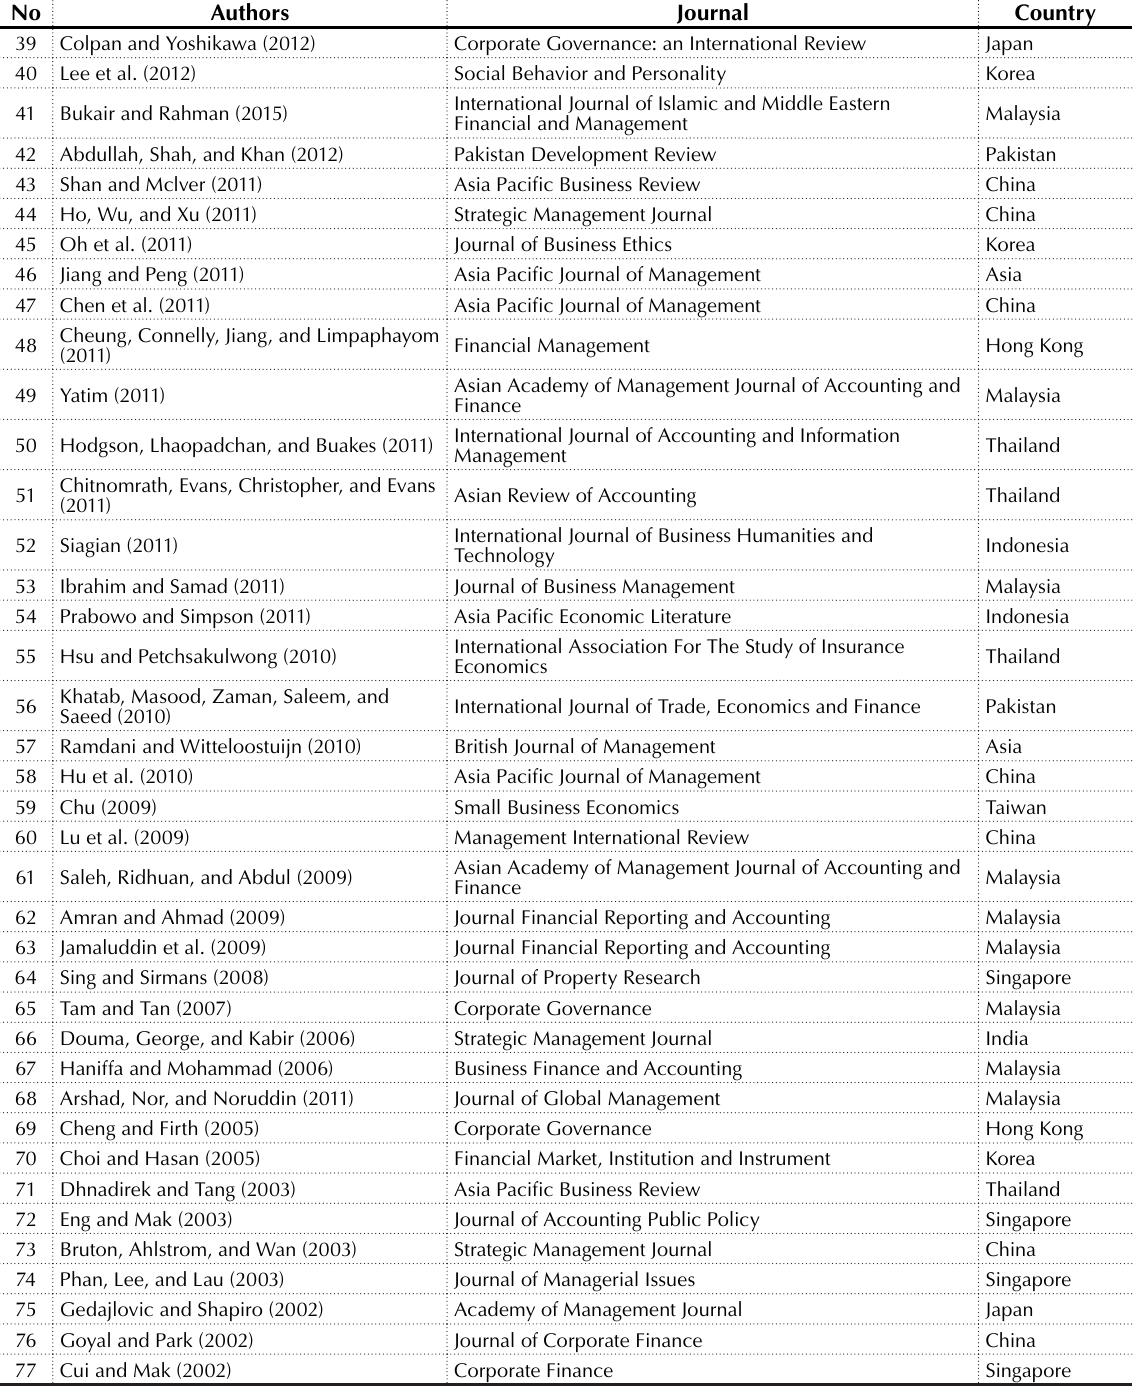
Table 1 (cont.). Studies included in